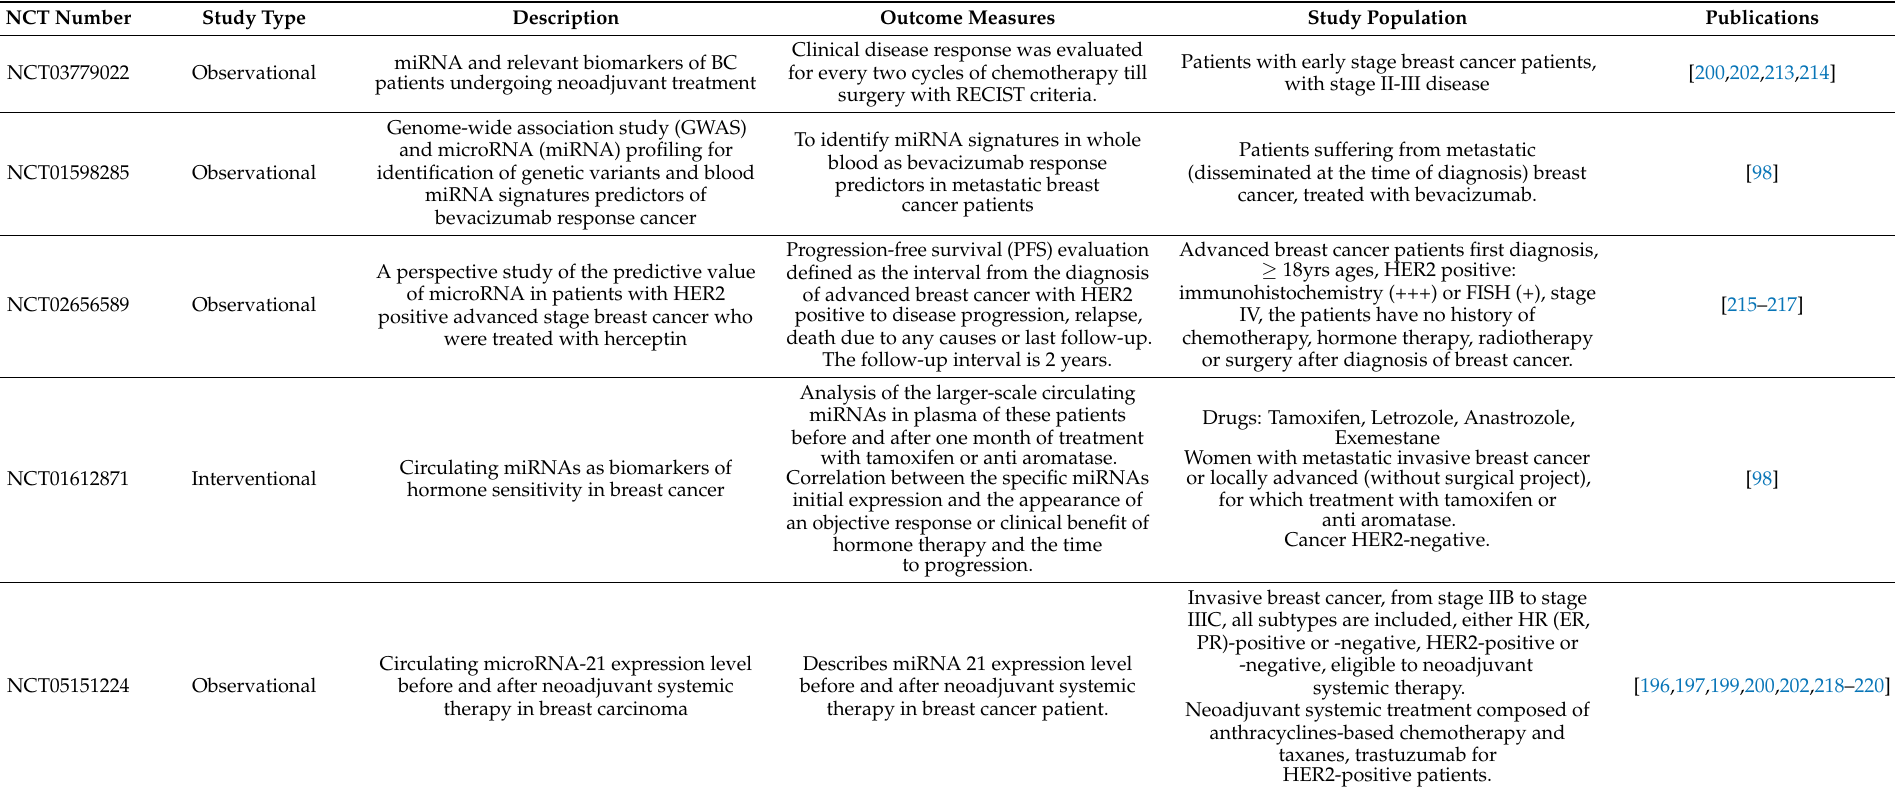
Table 3. Examples of clinical trials taking into account the importance of microRNAs in the treatment of breast